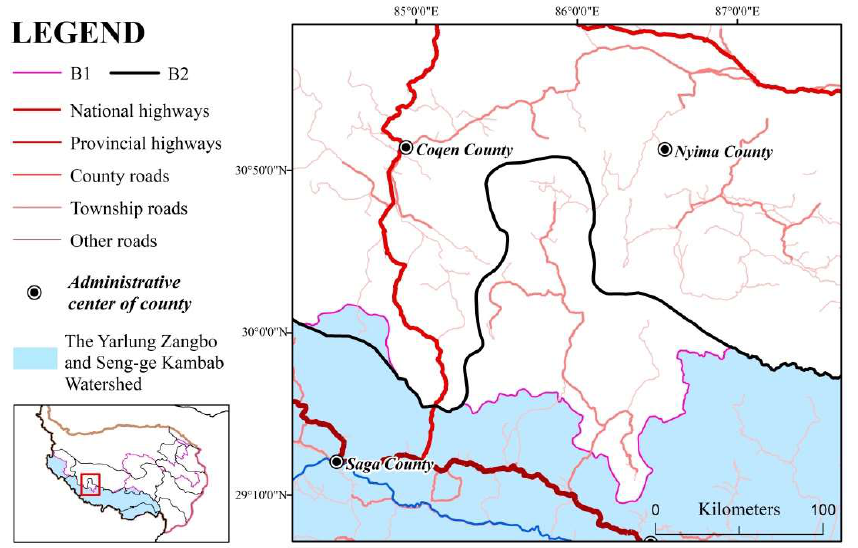
Figure 4. Example Area with B1 and B2. (At the junction of the three counties of Saga, Coqen, and Nyima, the basic boundary of the Yarlung Zangbo and Seng-ge Kambab River Basins (B1) is modified by the lowest-grade road breakpoint line (B2)).